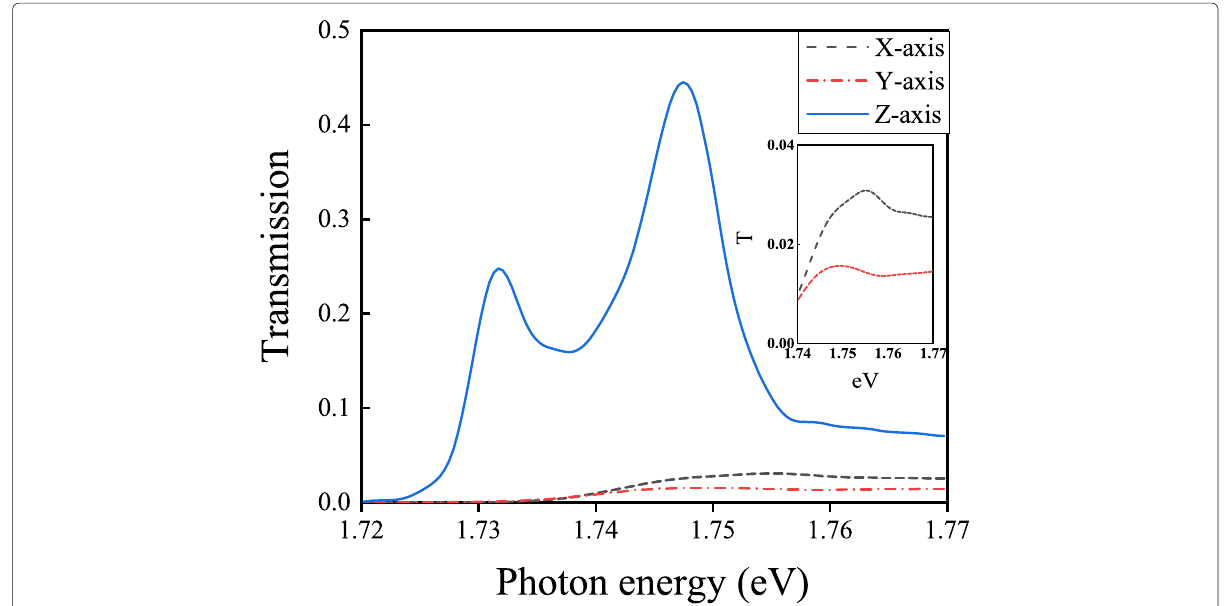
Fig. 7 Transmission spectra with a molecule polarized along the X, Y, and Z directions,